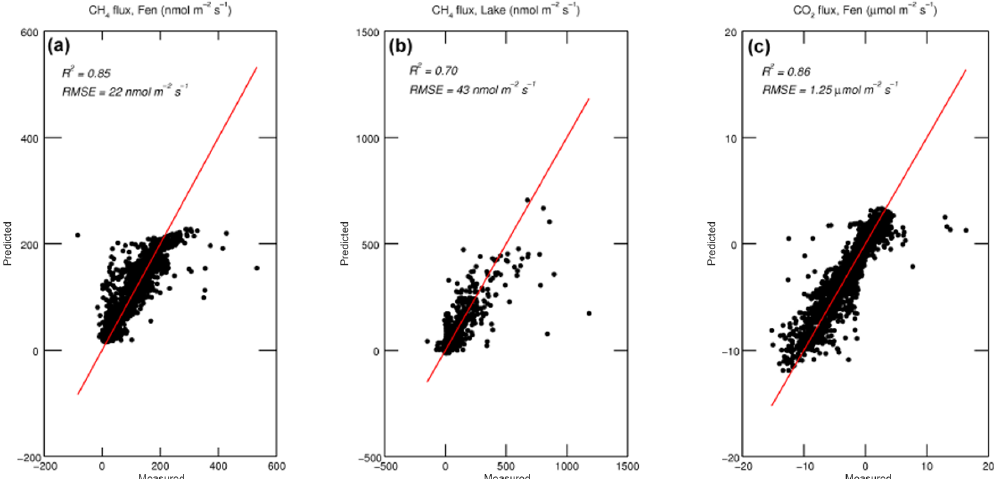
Figure 10. Evaluation of the artificial neural network models: measured vs. predicted hourly flux values for fen CH 4 fluxes (a) , lake CH 4 fluxes (b) , and fen CO 2 fluxes (c) . In red is the 1 : 1